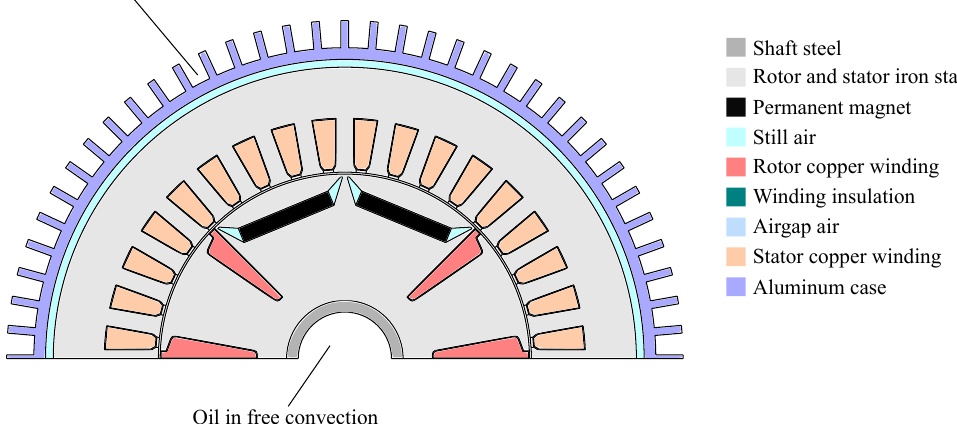
Figure 28. Motor model for the thermal finite element simulation of the HE-IPM motor with air cooling and oil flux along the